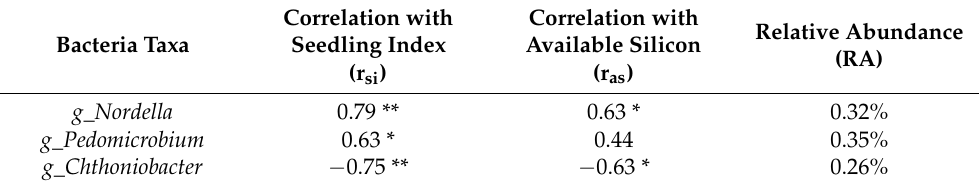
Table 2. The special bacterial groups (RA > 0.2%) correlated significantly with the seedling index and the available silicon content in the